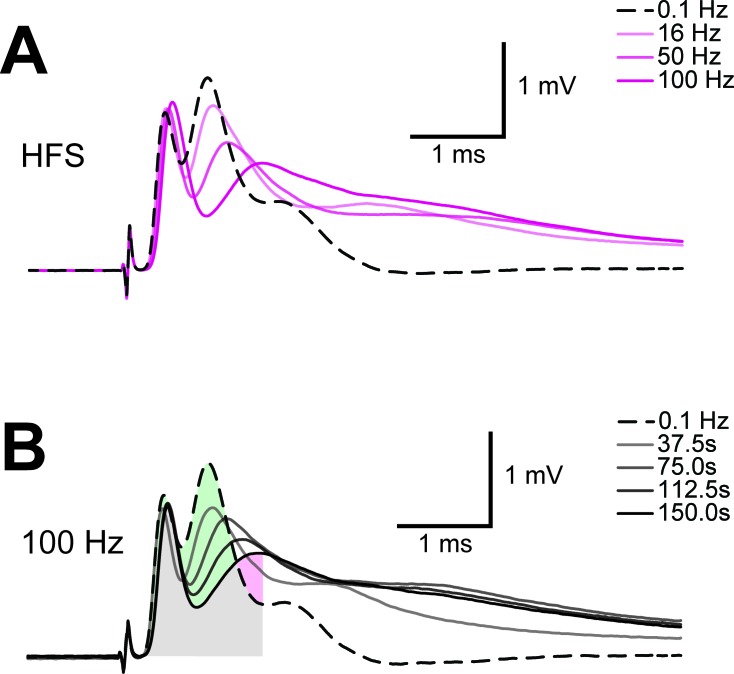
Example of progression of CAP traces’ decay during high frequency stimulation (HFS).(A) The three peaks recognizable in the baseline trace (dashed line) are differently affected by increasing stimulation frequency and for CAP analysis only the first two are considered. Shown are single traces obtained prior to stimulation (baseline) as well as at the end of a 2.5 min stimulation period at different stimulation frequencies (16 Hz, 50 Hz, 100 Hz) of a nerve incubated in aCSF containing 10 mM glucose. (B) Example of progression of CAP from baseline (dashed line) during stimulation of an optic nerve at 100 Hz incubated in aCSF containing 10 mM glucose for a total stimulation time of 2.5 min. Single traces are separated by 37.5 s. The shaded area indicates the area under the CAP wave form used for CAP quantification for the baseline condition (green) and after 150 s of HFS (red). Grey shading results from the overlay of green and red shading.